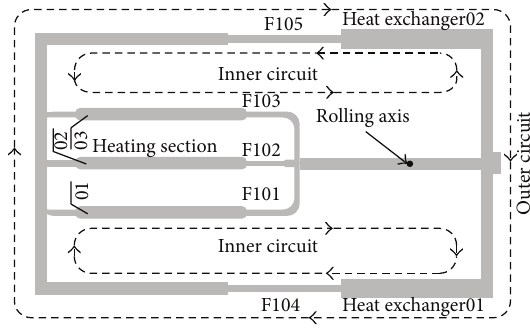
Figure 2: Structure of primary loop consisted of inner circuit and outer circuit.